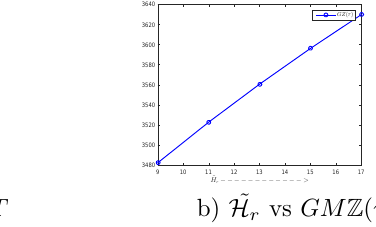
Figure 6. Sensitivity effect of parameter ˜ H o on Inventory.